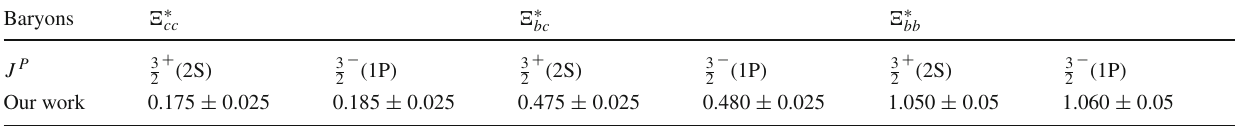
Table 3 The pole residues λ and ˜ λ of the excited states (2S) and (1P) of spin-(3/2) doubly-heavy baryons (cid:2) ∗ cc , (cid:2) ∗ Baryons